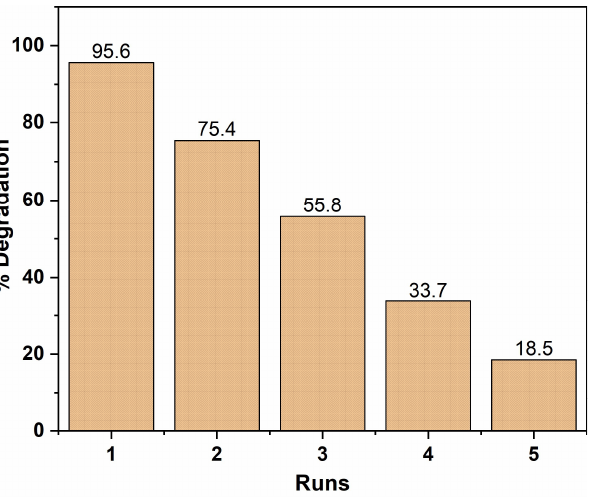
Figure 8. Recycling Study of FFGN for the catalytic oxidation of ANB (pH = 3.0 ± 0.2, ANB = 50 ppm, FFGN = 0.5 g/L, Na 2 S 2 O 8 = 0.06 mol/L, Amplitude = 40%, Probe = 25 mm, T = 25 ± 1 °C) .